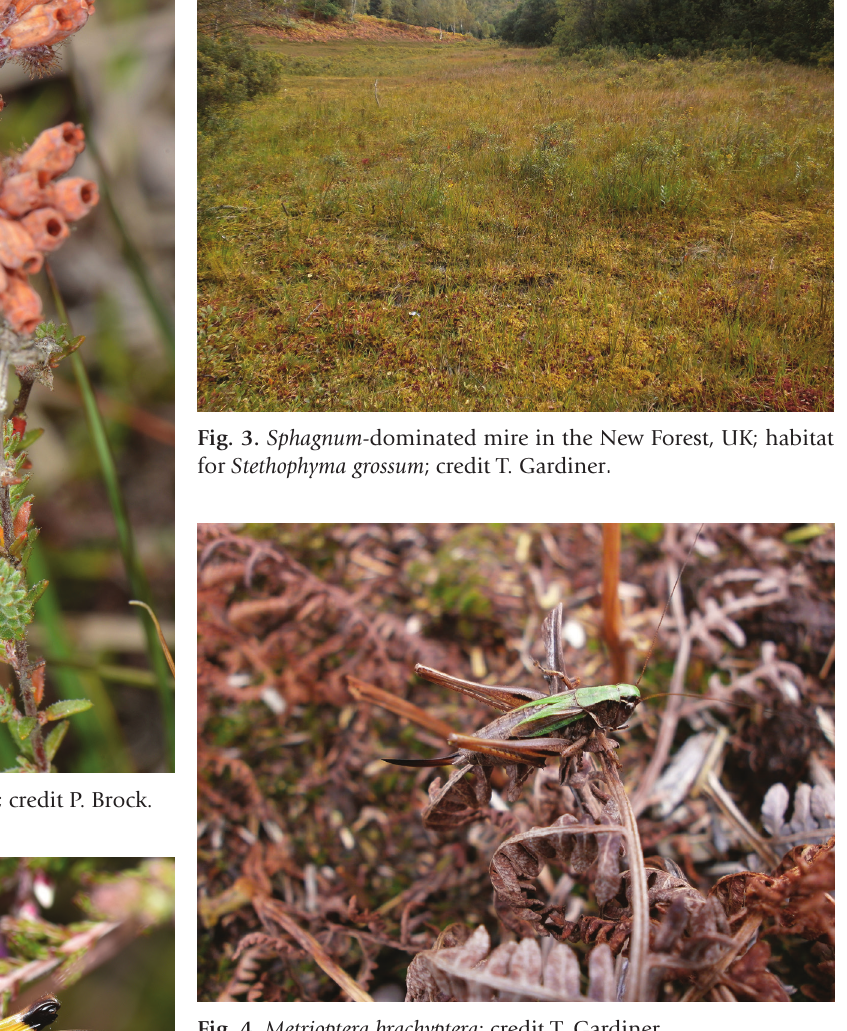
Fig. 4. Metrioptera brachyptera ; credit T. Gardiner